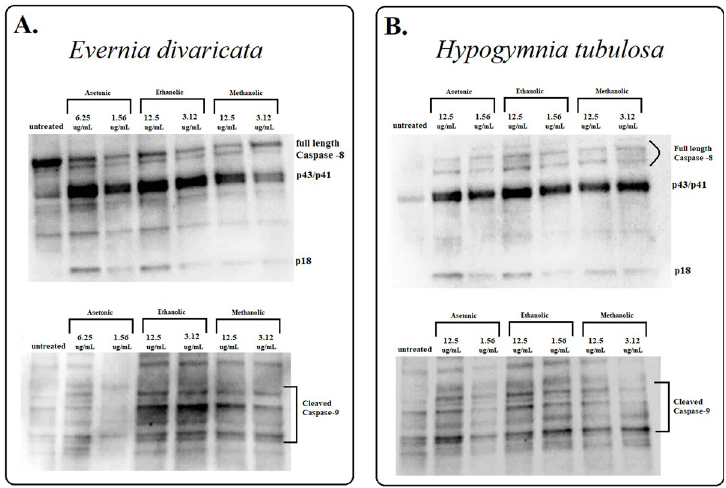
Fig 7. Determination of caspase-8 and caspase-9 protein levels from Evernia divaricata and Hypogymnia tubulosa with acetone, ethanol and methanol extracts on PC3 cells. A. Caspase-8 protein expression of Evernia divaricata with acetone, ethanol and, methanol extraction at 24, 48, 72 hours of treatment respectively (upper side). Cleaved caspase-9 protein expression of Evernia divaricata with acetone, ethanol and, methanol extraction at 24, 48, 72 hours of treatment respectively (lower side) B. Caspase-8 protein expression of Hypogymnia tubulosa with acetone, ethanol and, methanol extraction at 72 hours of treatment respectively (upper side). Cleaved caspase-9 protein expression of Hypogymnia tubulosa with acetone, ethanol and, methanol extraction at 72 hours of treatment respectively (lower side).